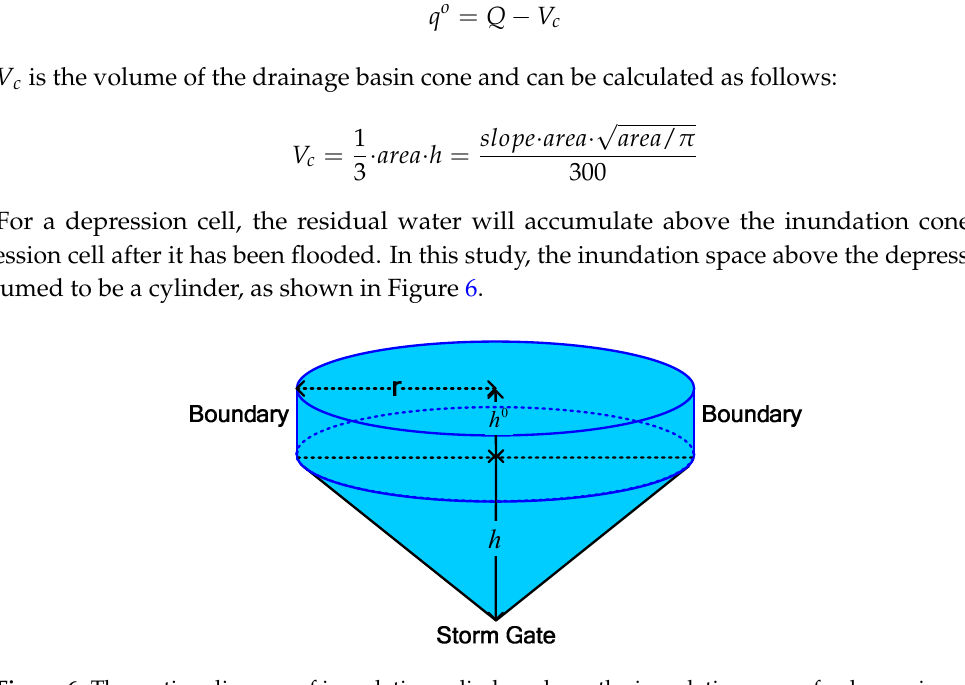
Figure 6. The section diagram of inundation cylinders above the inundation cone of a depression cell.